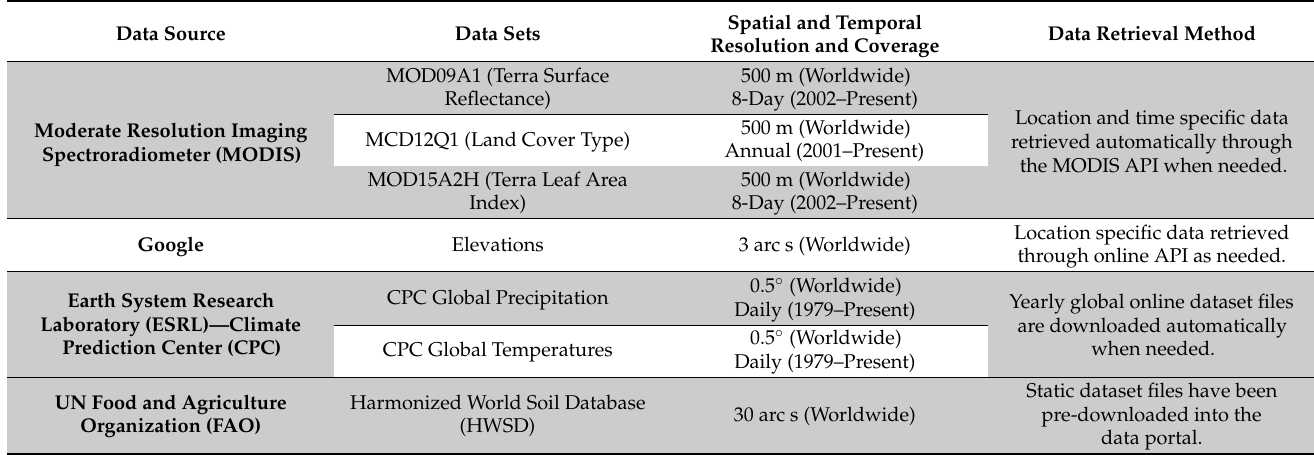
Table 1. Data sources and data sets used by the Large Basin Data Portal and their respective spatial and temporal resolution, spatial and temporal coverage, and retrieval methods.